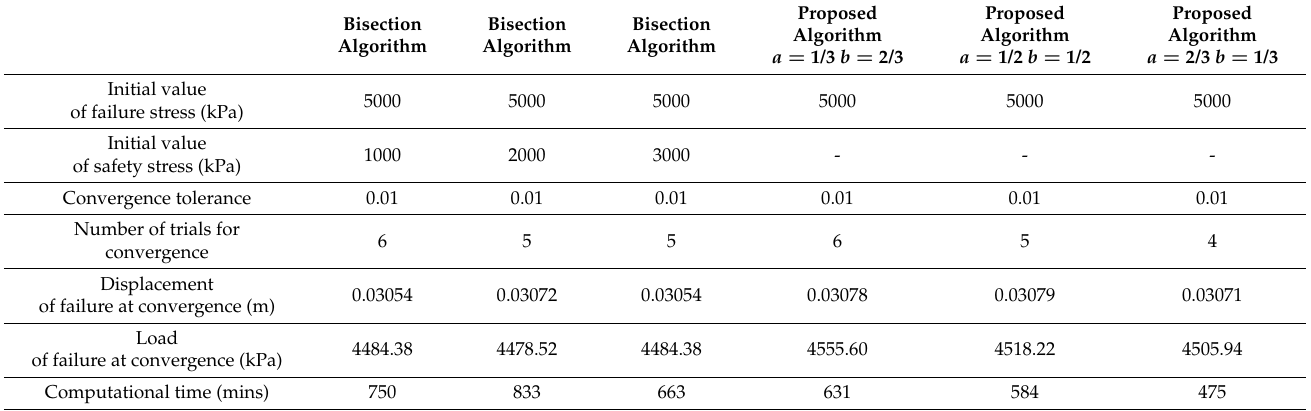
Table 1. Comparison of the proposed algorithm with the bisection method for the calculation of the failure load λ ∗ and failure